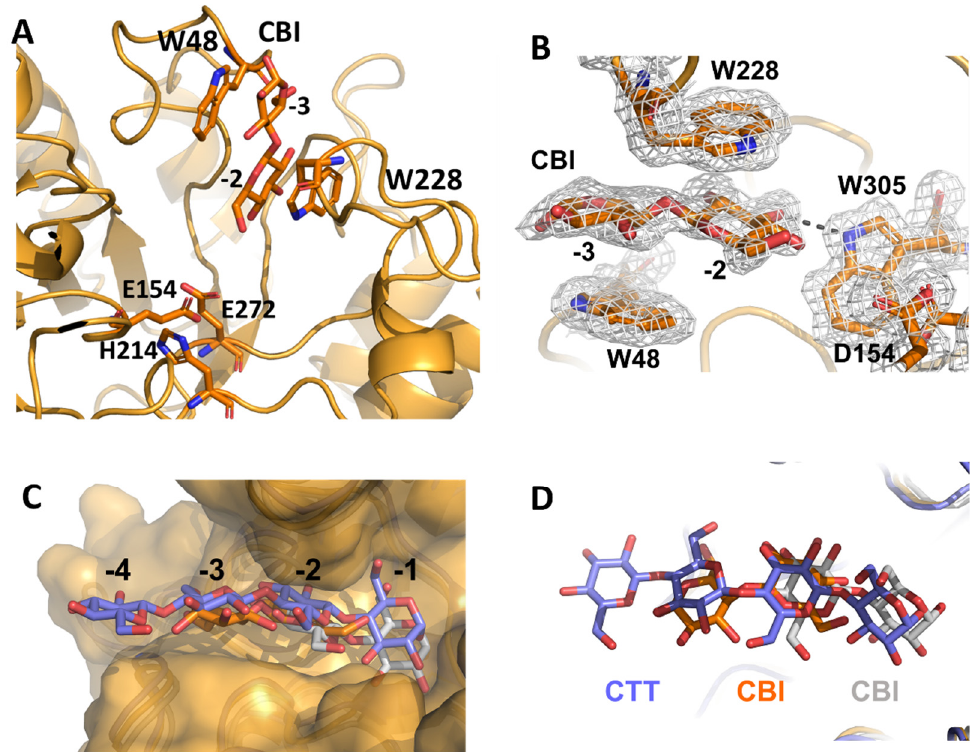
Figure 6. Crystal structure of DtCel5A in complex with cellobiose (CBI). ( A ) CBI binding mode in DtCel5A; ( B ) Omit (Fo-Fc) electron density map, contoured at 2.0 σ , showing a cellobiose molecule bound to the catalytic site of DtCel5A; ( C ) Surface representation of DtCel5A and stick representation of CBI bound to DtCel5A (orange/red); ( D ) Positions of CBI (grey/red) and cellotetraose (CTT, blue/red) bound to Cel5A of T. maritima (pdb codes 3azr and 3azt, respectively) were obtained upon superposition with the two protein structures.